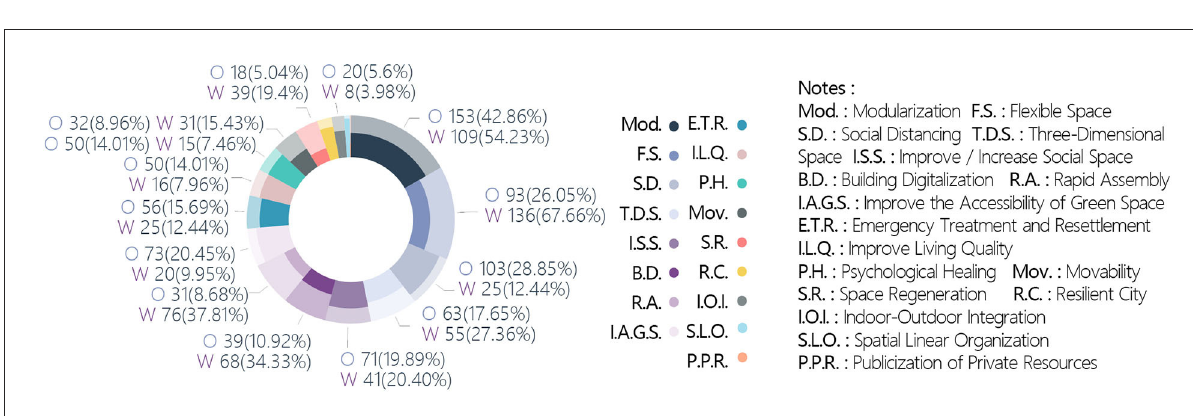
FIGURE9 Cross-tabulation results with territory and